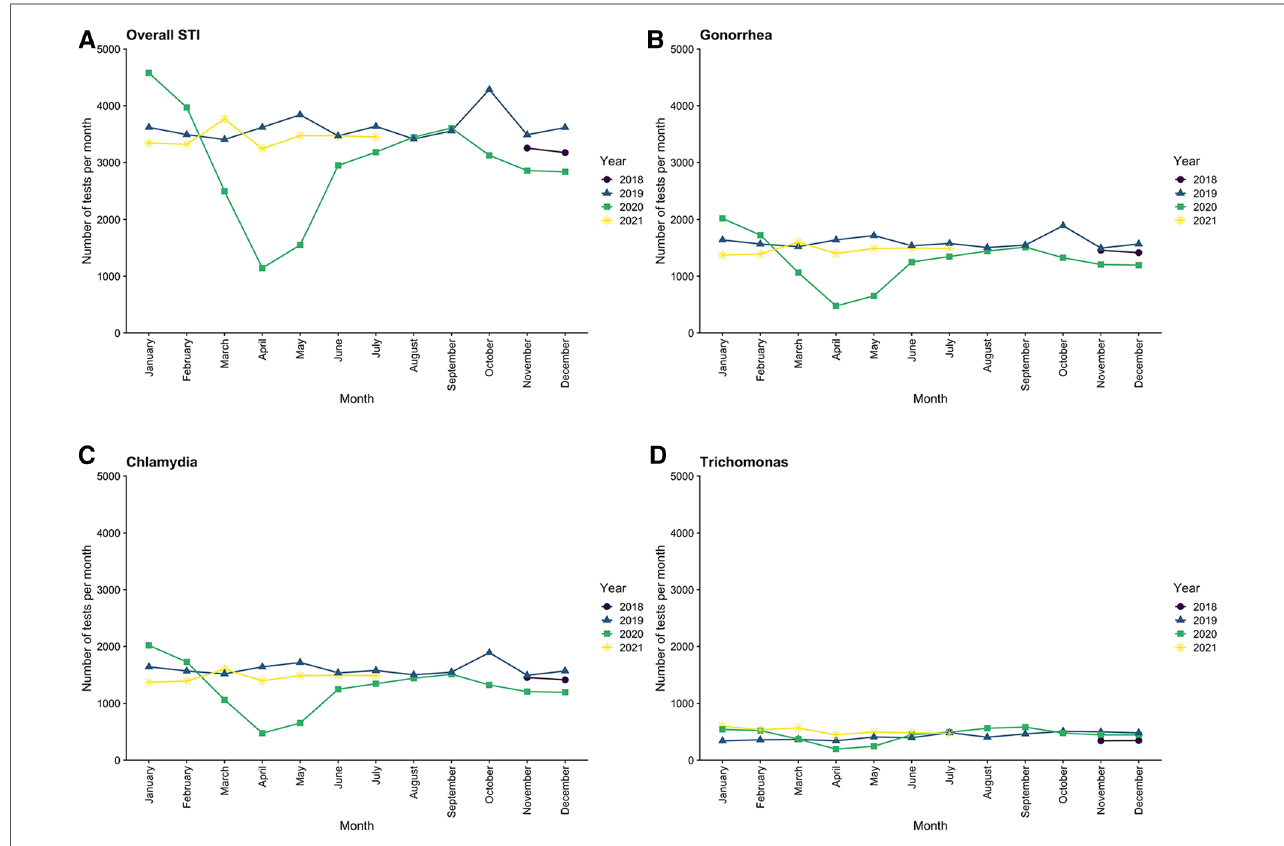
FIGURE 2 Trends in testing rates for sexually transmitted infections across the entire medical center by month, from November 2018 through July